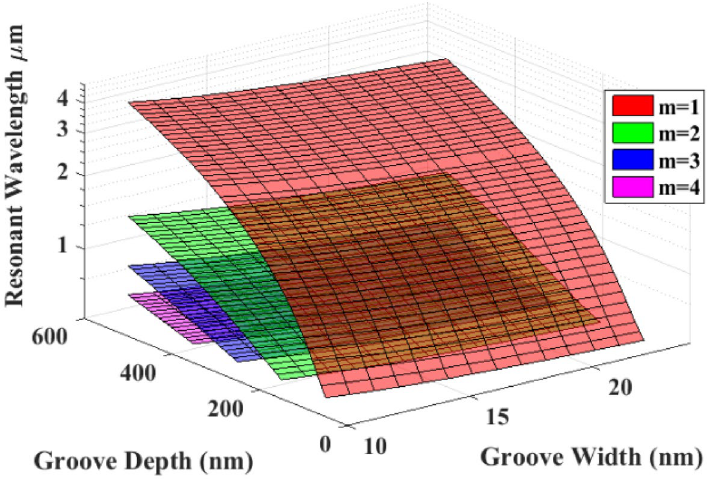
Figure 2. Theoretical relationship between groove depth, groove width, and the resonant wavelength of a single groove. m represents the mode number of the resonating field within the cavity. Note that the resonant wavelength can be controlled by changing either the groove width or